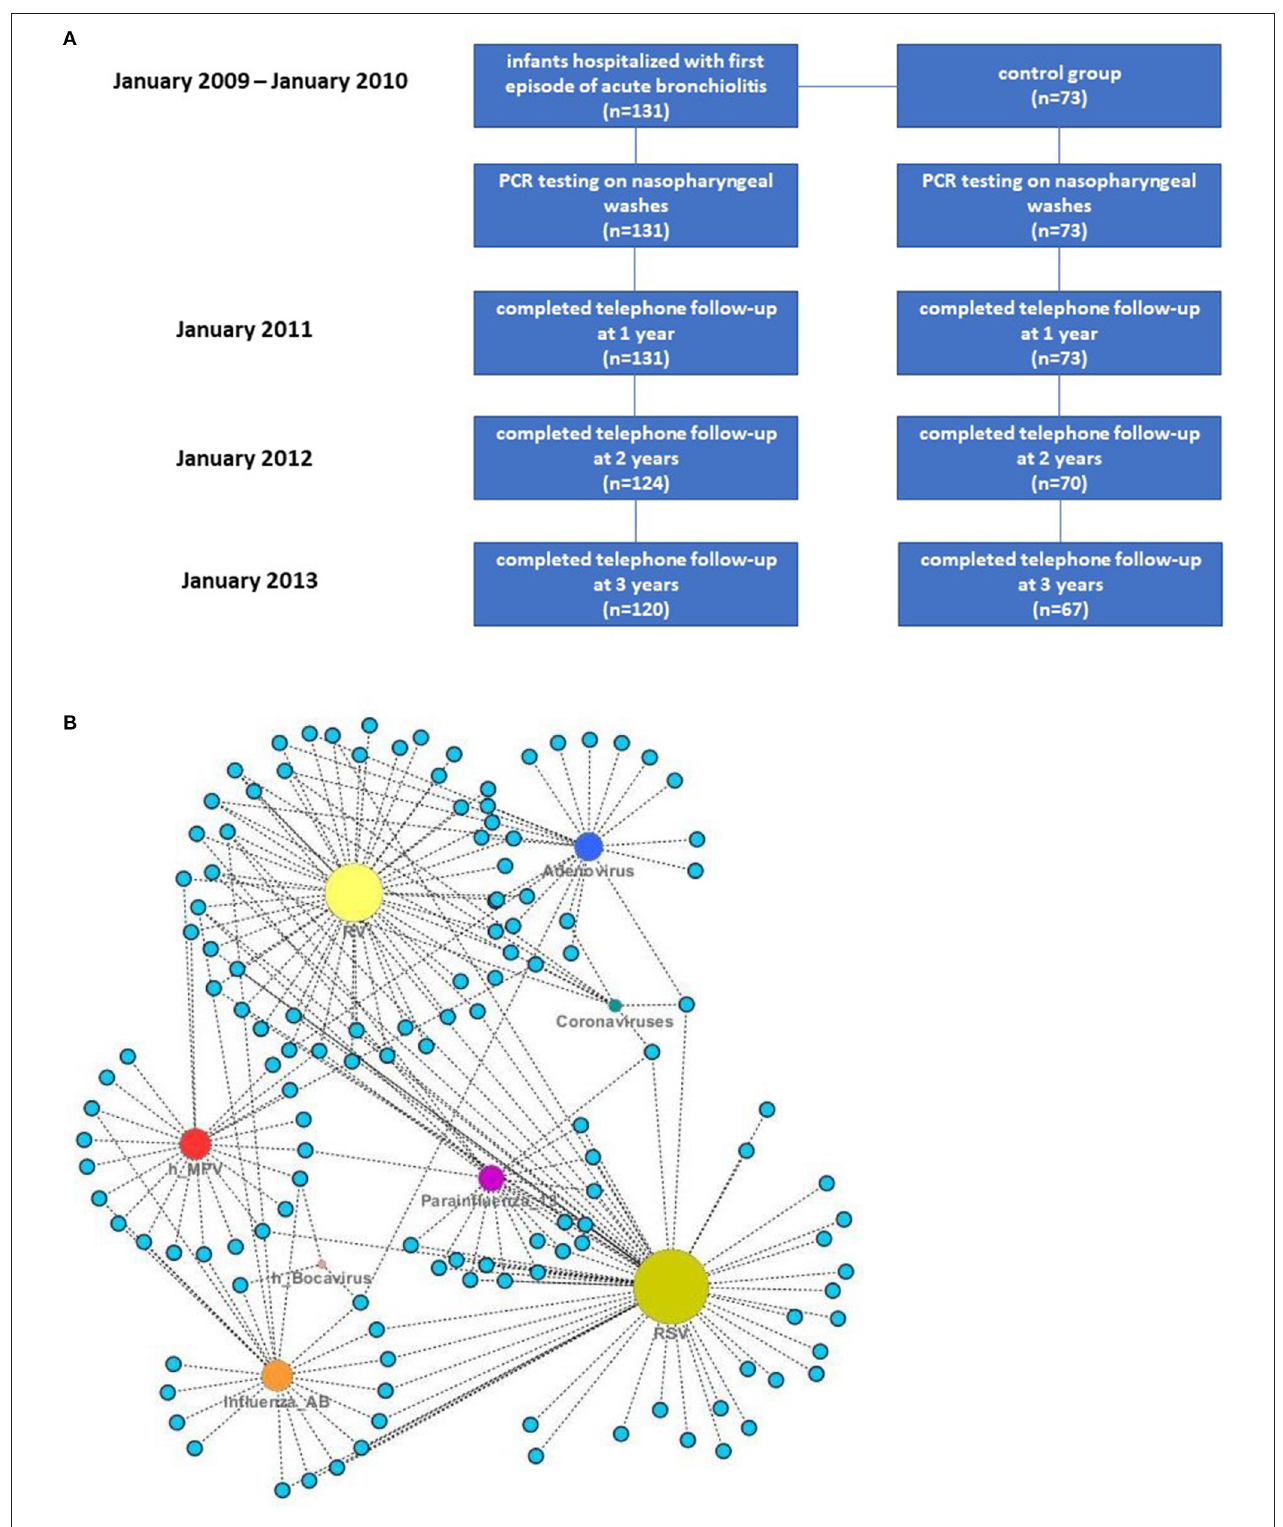
FIGURE 1 | (A) Flow diagram describing patients’ recruitment and follow-up. (B) Absolute frequencies of viruses detected in nasopharyngeal washes of infants with bronchiolitis and control patients—each node represents a patient and size is related to the frequency of detected viral agents.